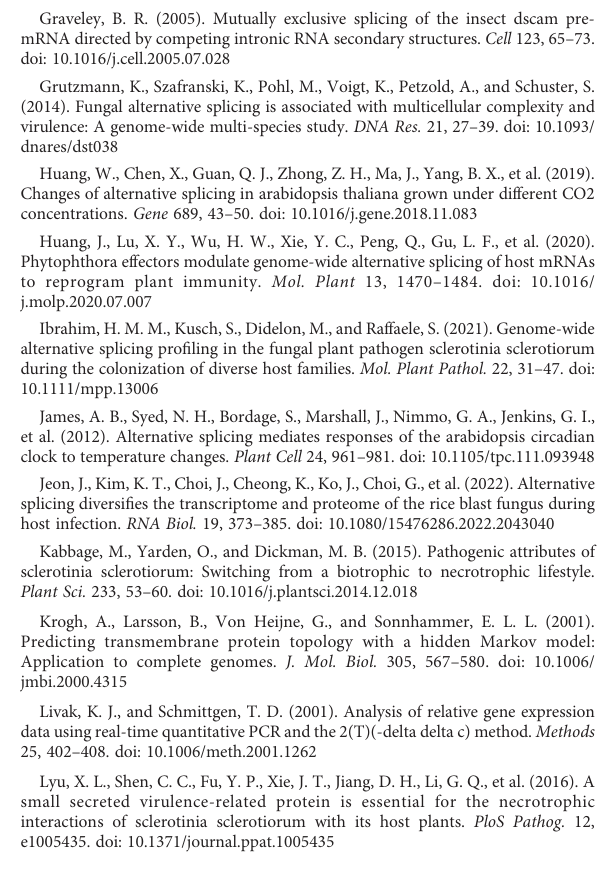
under fi ve alternative splicing types. A3SS, alternative 3 ′ splice site; A5SS, alternative 5 ′ splice site; ES, exon skipping; RI, retained intron; MXE, mutually exclusive exon. SUPPLEMENTARY FIGURE 3 Top 20 Gene Ontology (GO) enrichment biological processes of differentially expressed genes and differential alternative splicing genes. The x -axisrepresentsthenegativelog 10 ofthe P -valuesforeachGOterm, and the y -axis indicates the GO terms. SUPPLEMENTARY FIGURE 4 Sashimi plots for differential alternative splicing genes (DASGs) in each alternative splicing type. The plots indicate the average RNA-seq read density and splice junction counts for each DASG. The x -axis indicates genomic coordinates, and the y -axis indicates per-base expression. The numbers in the fi gure show the count of reads across this junction or in this area. The bottomtrackrepresentstheexon – intronstructure(exonsinblackandintrons aslines)ofalternativeisoforms. (A) Sashimiplotofgene Sscle_03g022490 with A3SS event. (B) Sashimi plot of gene Sscle_01g000960 with A5SS event. (C) Sashimiplotof gene Sscle_01g010310 withSEevent. (D) Sashimiplotofgene Sscle_01g007440 withRI event. SUPPLEMENTARY FIGURE 5 Expression patterns of two hub genes in the STRING network. The x -axis represents the infection stages. The y -axis represents the fragments per kilobase of transcript sequence per million base pairs mapped reads value of the